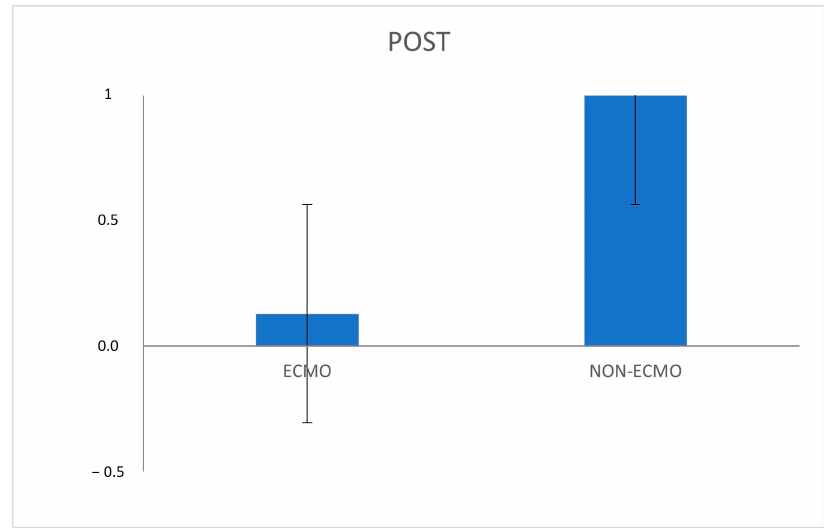
Figure 4. Real-time PCR for iNOS expression performed in 12 cases (6 ECMO and 6 non-ECMO patients post-reperfusion). Fold changes between ECMO and non-ECMO patients post-reperfusion showed higher median Δ Ct values in the non ECMO group in comparison to the ECMO group, even if not significant. Data are expressed as 2-° ∆ Ct values (the value was assumed to be 1 for the ECMO group).